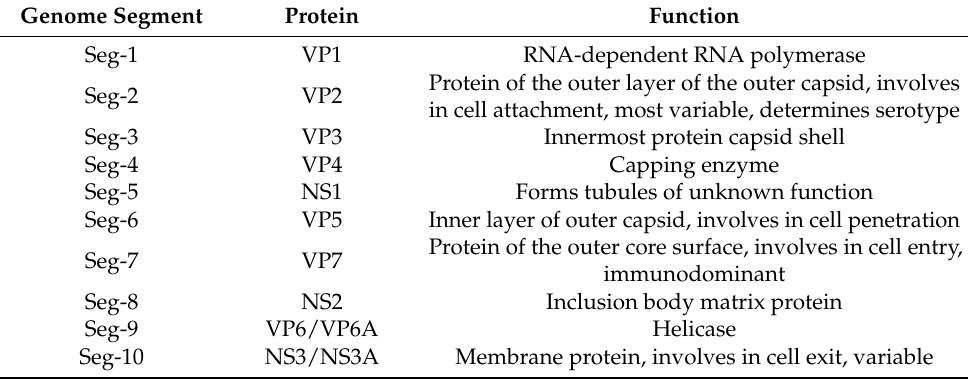
Table 1. Genome segments and protein encoded by each segment of EEV (similar to other Orbiviruses